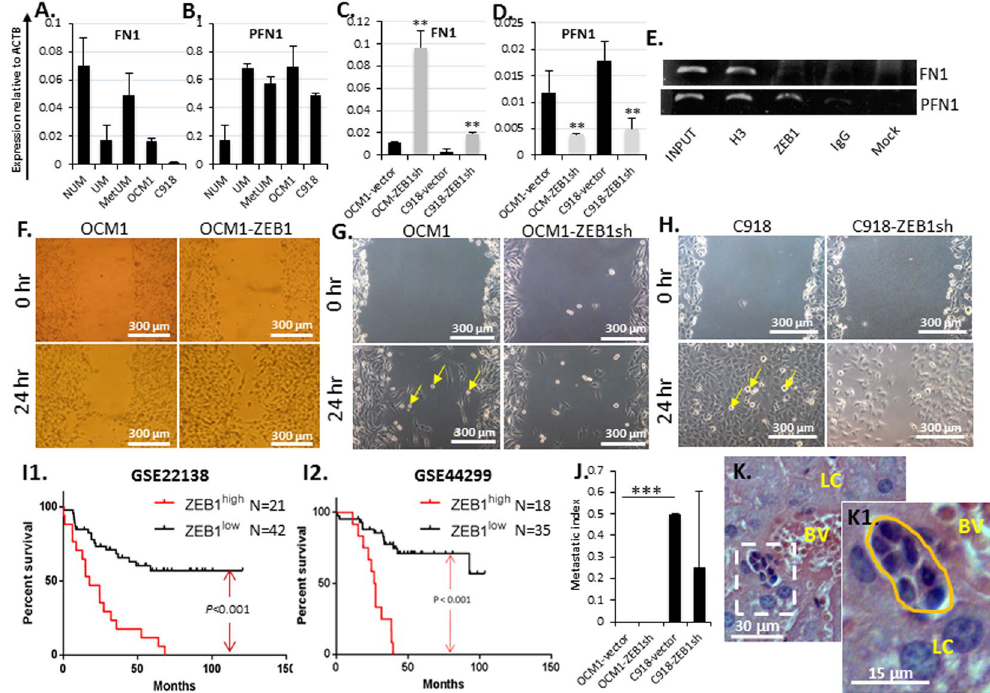
Figure 8. ZEB1 facilitates UM cell migration. Transcriptional analyses showed that ( A ) the major component of extracellular matrix (ECM) fibronectin ( FN1 ) and ( B ) the locomotion protein profilin ( PFN1 ) were under- or over-expressed in UM, MetUM, and UM cell lines, respectively. Knockdown of ZEB1 increased ( C ) FN1 but decreased ( D ) PFN1 expression accordingly. ( E ) ChIP assays showed that ZEB1 bound to both FN1 and PFN1 promoters. Detected by scratch assays, ( F ) overexpression of ZEB1 in OCM1 increased cell migration while knockdown of ZEB1 in ( G ) OCM1 and in ( H ) C918 cells reduced their migration to cross the scratched gap. Yellow arrows indicate that semi-suspended cells detached from the monolayer culture are of amoeboid cell shape. ( I ) Kaplan-Meier survival curves of two large cohorts of total 63 and 53 primary UMs, respectively (microarray data sets GES22138 and GES44299, downloaded from NCBI database, Supplemental Tables 4 and 6), were generated and compared between ZEB1 high group (n = 21 or 18) and ZEB1 low group (n = 42 or 35). ( J ) Equal number of OCM1- and C918-vector controls and ZEB1sh knockdown cells (2 × 10 5 ) were intravitreously injected into the nude mice and their 25-day grafted ocular tumors were examined for potential metastasis evaluation. ( K ) A representative image where potential metastatic cells are seen to be close to a blood vessel (BL) and surrounded by the normal liver cells (LC) 25 days after intravitreal injection of C918-vector control cells. Mean (M) ± standard deviation (SD). Student’s t-tests were performed. ‘ ** ’ Indicates p ≤ 0.01. *** Indicates p ≤ 0.001. Yellow arrows indicate amoeboid-like cell